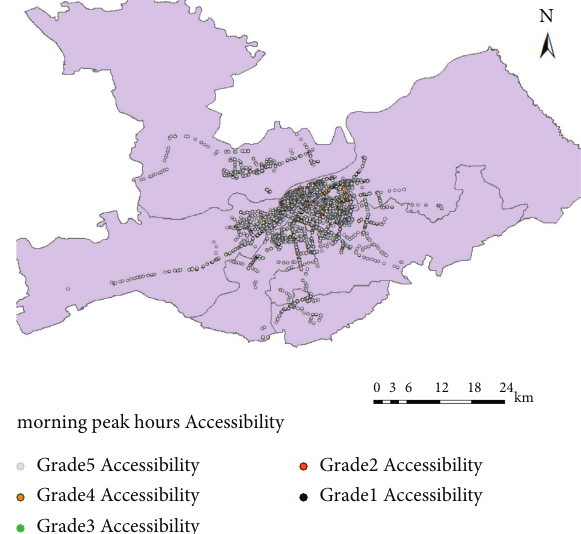
Figure 6: Spatial distribution of accessibility performance in evening peak hours.